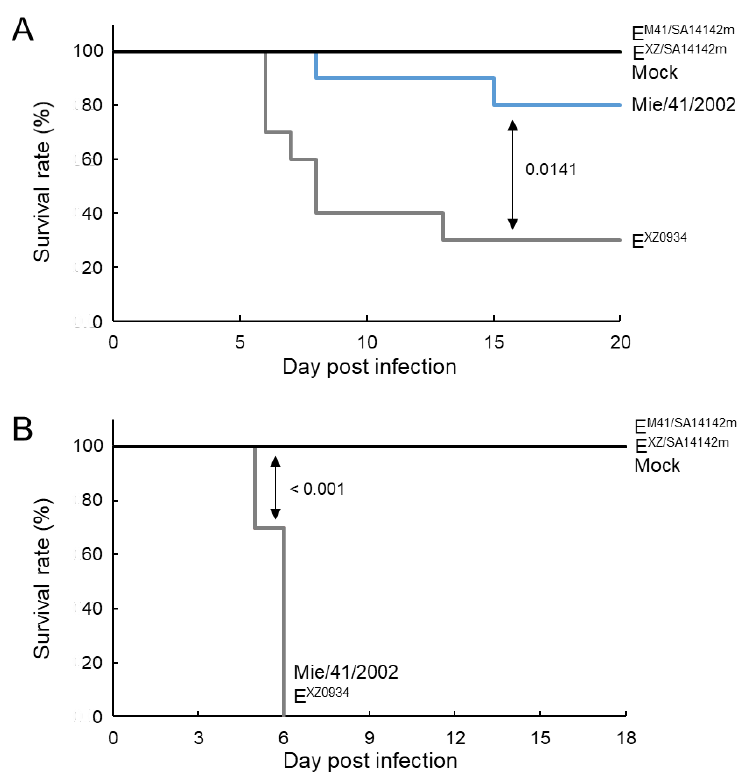
Figure 3. Murine neuroinvasiveness ( A ) and neurovirulence ( B ) of recombinant JEV strains. ( A ) Survival curve of mice inoculated intraperitoneally (i.p.) with 1 × 10 5 PFU of Mie/41/2002 ( n = 10), E M41/SA14142m ( n = 10), E XZ0934 ( n = 10), or E XZ/SA14142m ( n = 10) and mice mock-inoculated ( n = 10). ( B ) Survival rate of mice inoculated intracerebrally with 3 × 10 3 PFU of Mie/41/2002 ( n = 10), E M41/SA14142m ( n = 10), E XZ0934 ( n = 10), or E XZ/SA14142m ( n = 10) and mice mock-inoculated ( n = 10). Significant p values by log-rank test are also indicated.